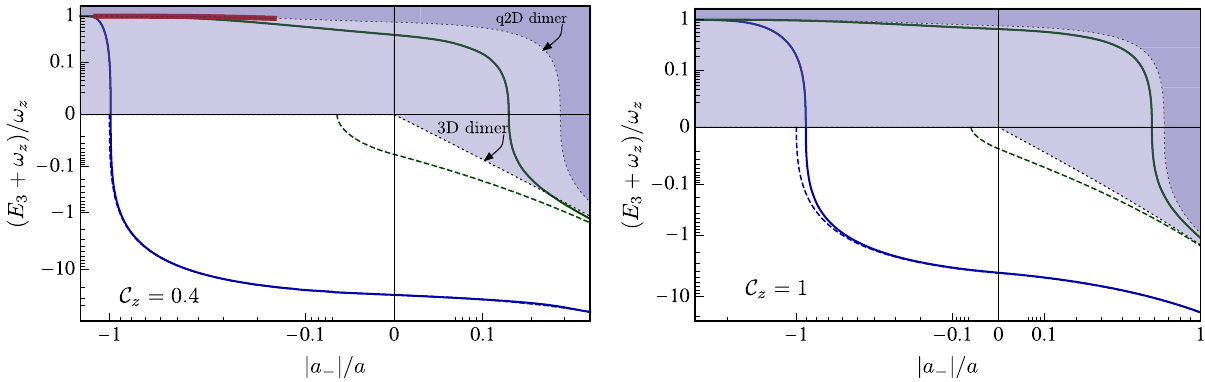
FIG. 2. Spectrum of trimers for two different confinement strengths. The q2D trimers are shown as solid lines, with energies E 3 þ ω z that take into account the raised three-atom continuum under confinement. For comparison, we also include the two deepest trimers in 3D (dashed lines). The shading illustrates the atom-dimer and three-atom continua, where the q2D continuum (contained within the 3D ¼ 1 (right panel), only two q2D trimers exist. For a weaker continuum) is shown with a darker shading. For a strong confinement with C z ¼ 0 . 4 (left panel), a third weakly bound trimer appears that is indistinguishable from the atom-dimer threshold on confinement with C z this scale; here, we show its region of existence as a thick, red line on top of the threshold (see Fig. 3 for a clearer rendering). In order to ð x Þ ¼ sgn ð x Þ ln ½ 1 þ 5 j x j j (cid:2) = ln 6 , with aid the visibility over the large energy range here, we rescaled the axes by means of the function F j j ¼ 1 for the x axis and j ¼ 1 = 2 for the y axis. For the 3D spectrum, ω E 3 as a function is not defined, and we display ma 2 − C − 2 z z of j a − j =a